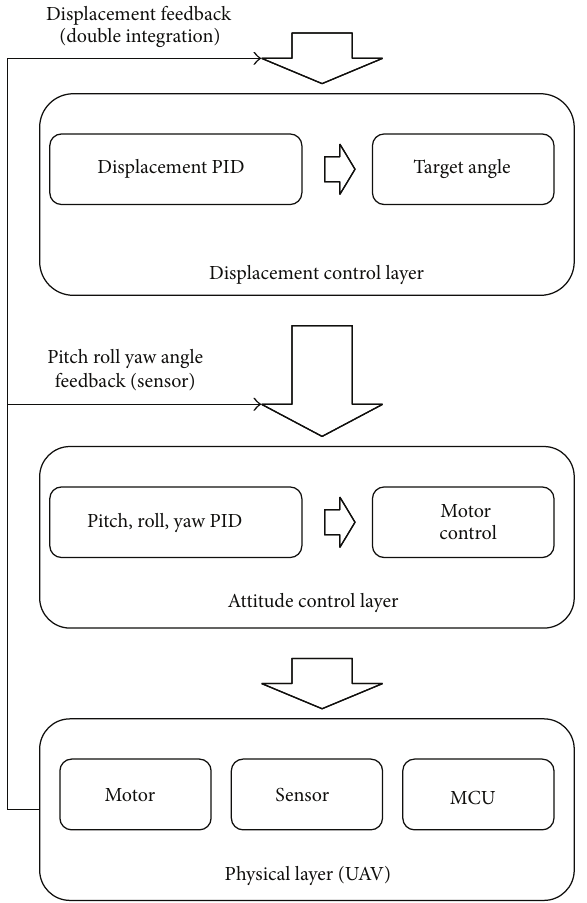
Figure 1: Architecture of the multilayered drift-stabilization control